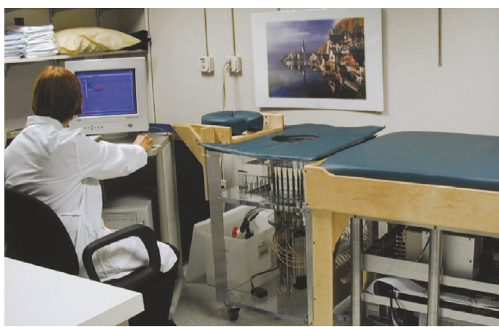
Figure 7: The microwave breast imaging system at Dartmouth College [17]. Image copyright IEEE, used with permission.